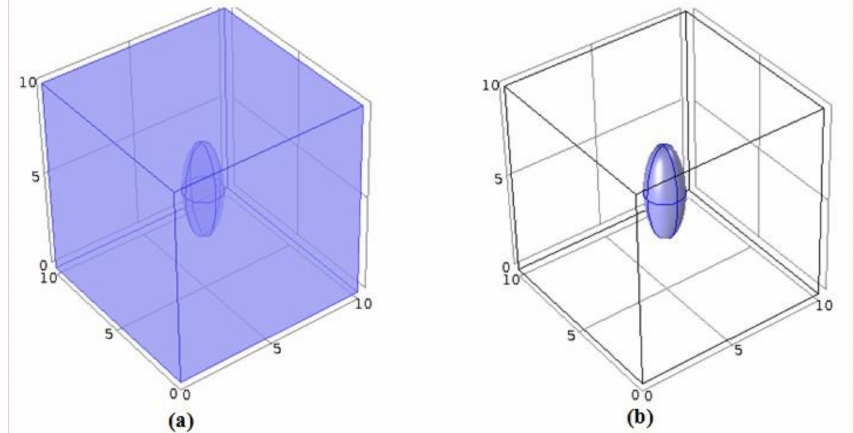
Figure 8. ( a ) Linear elastic dielectric solid, ( b ) electromechanical